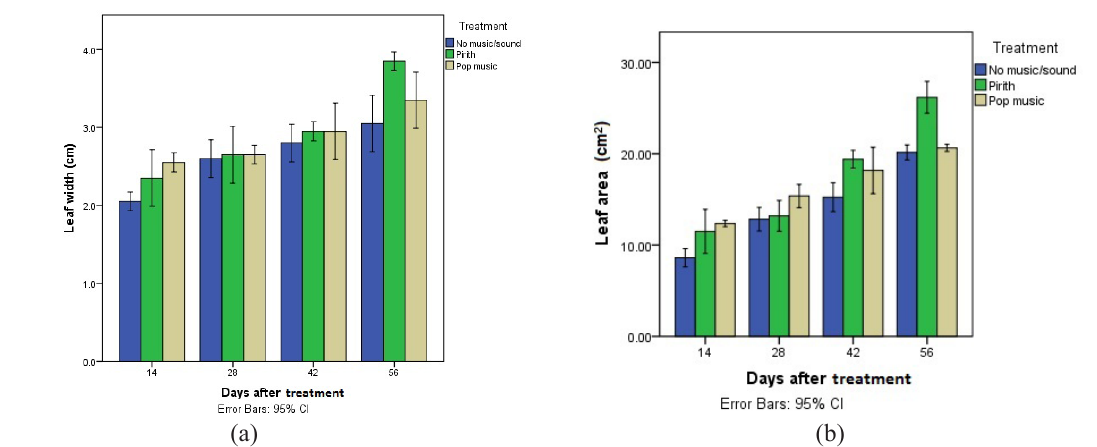
Figure 3: Variation of leaf width and leaf area under different sound treatments with time on (a) leaf width and (b) leaf